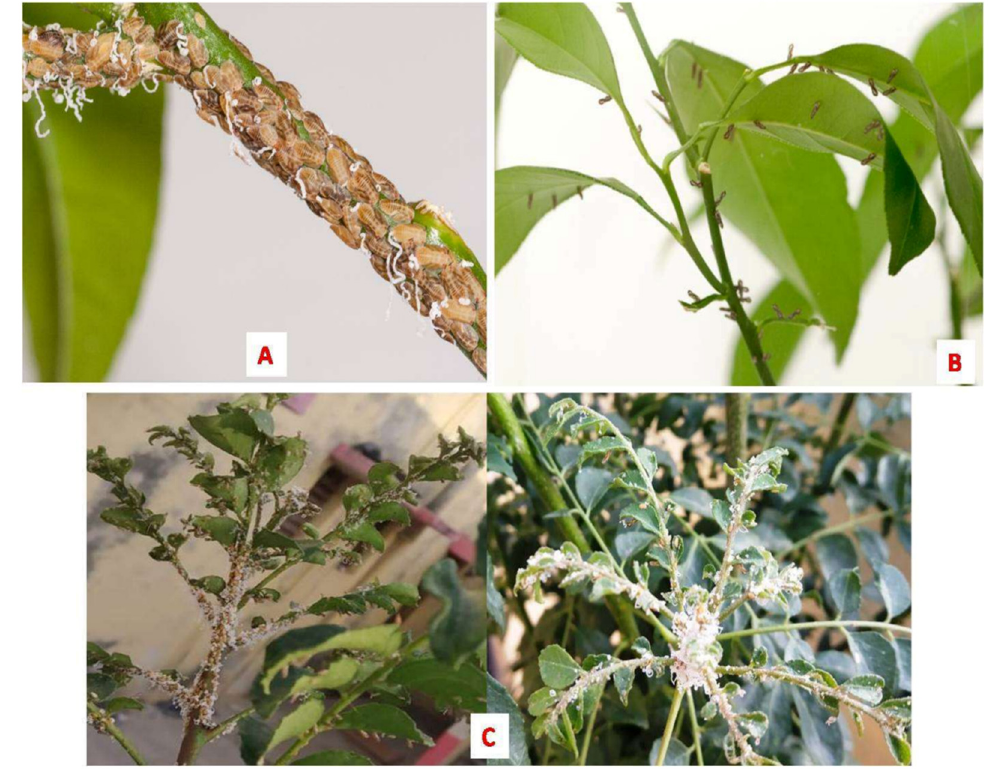
Figure 3. ( A ) ACP nymph on a citrus plant in the field. ( B ) ACP adults feeding on the leaf. ( C ) Infestation of ACP nymph and adults on curry leaf plants.